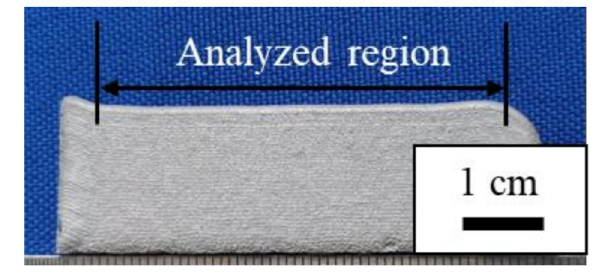
Figure 4. Front view of the thin-walled sample and analyzed